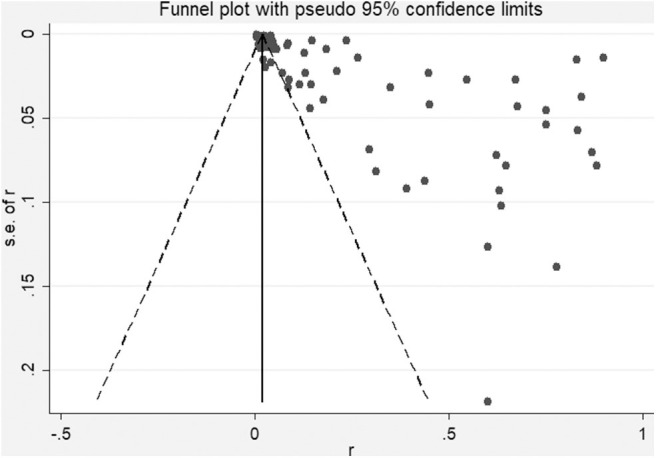
Heterogeneity among the included studies. Dots represent individual studies.